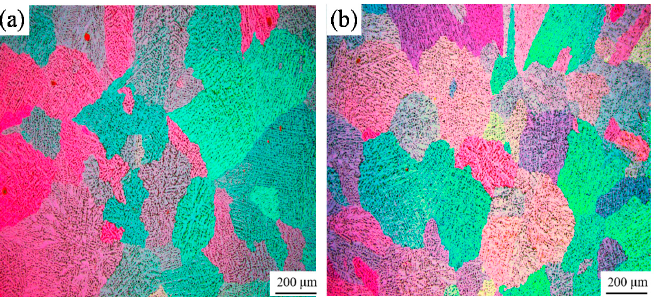
Figure 2. The metallographic structure of 1561 aluminum alloys. ( a ) the A1 plate; ( b ) the A2 plate.